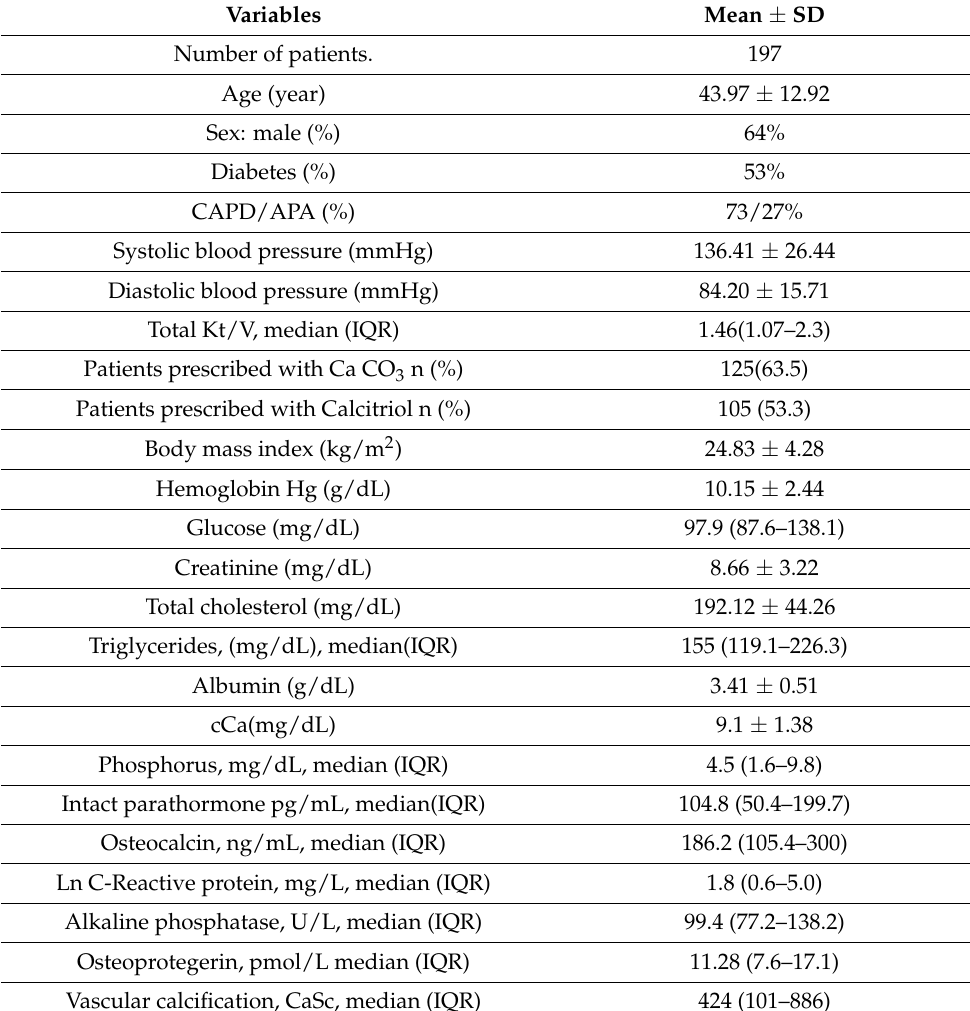
Table 1. Patient´s demographic, clinical and biochemical data.